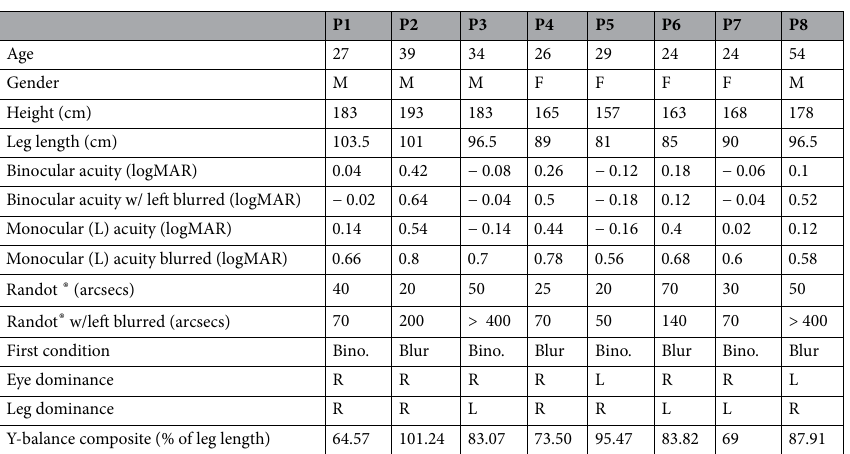
Table 1. Participant visual and demographic characteristics—normally sighted